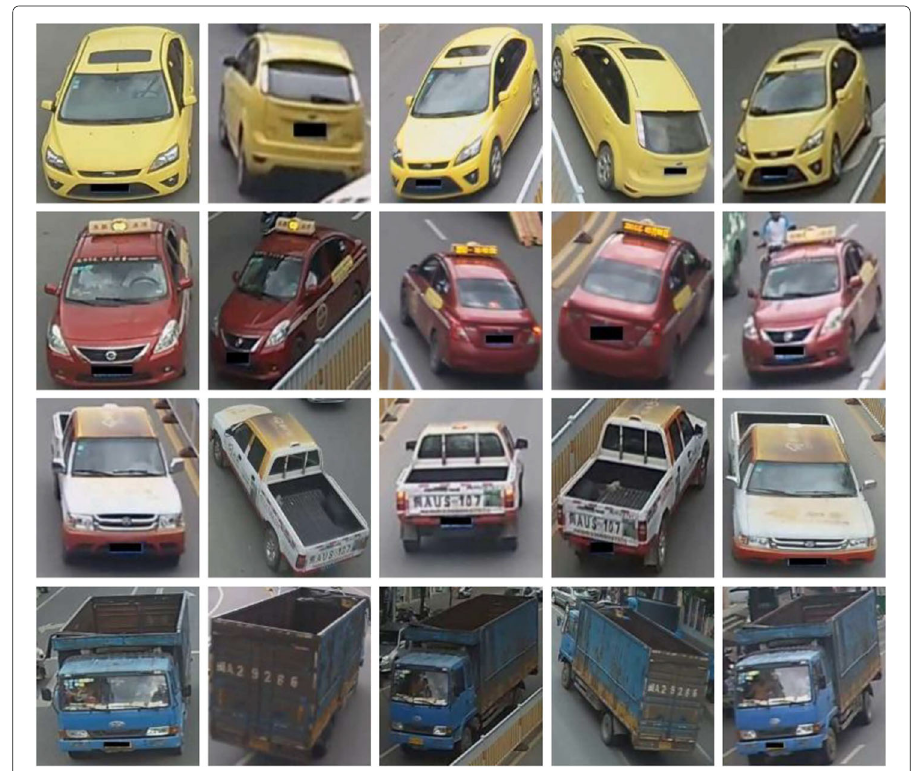
Fig. 1 Vehicle samples from the VeRi776 [1] dataset. Each row denotes vehicles of the same identity